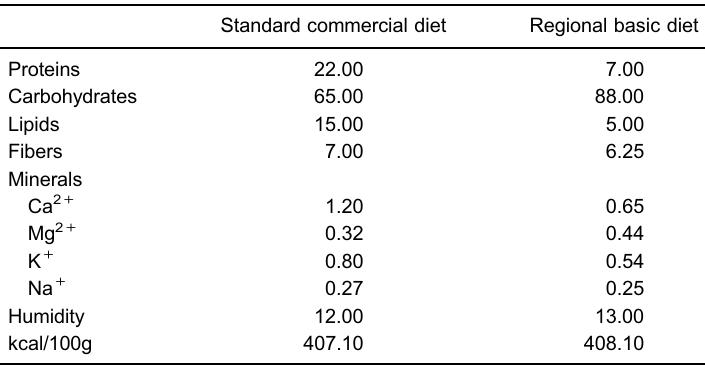
Table 1. Nutritional composition (g/g%) of the multide fi cient regional basic diet (RBD) and the standard commercial control diet.